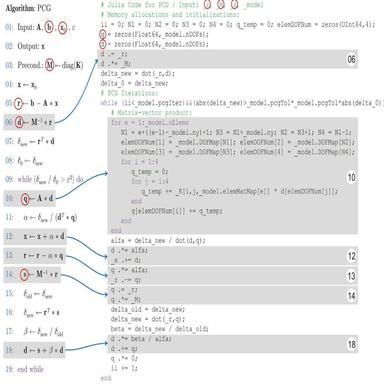
PCG algorithm (left) and EBE implementation in Julia (right).